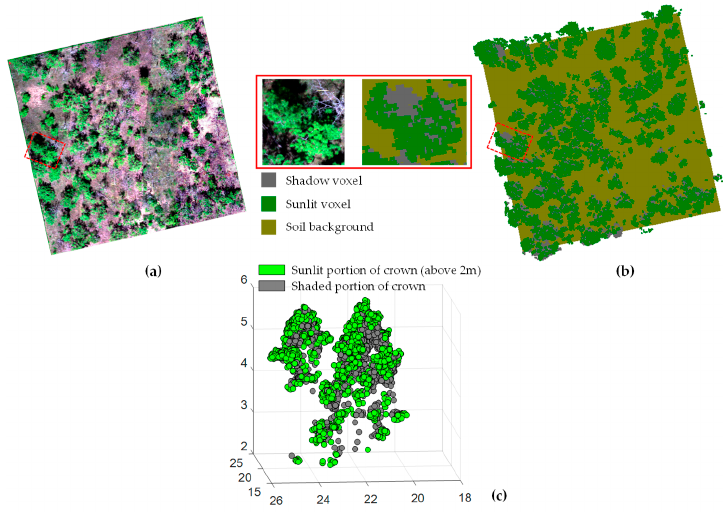
Figure 3. ( a ) HI data; ( b ) 3D forest scene with sunlit and shaded tree crowns modelling by RAPID (top-view); ( c ) classifying cloud points into sunlit and shaded portions (side-view).